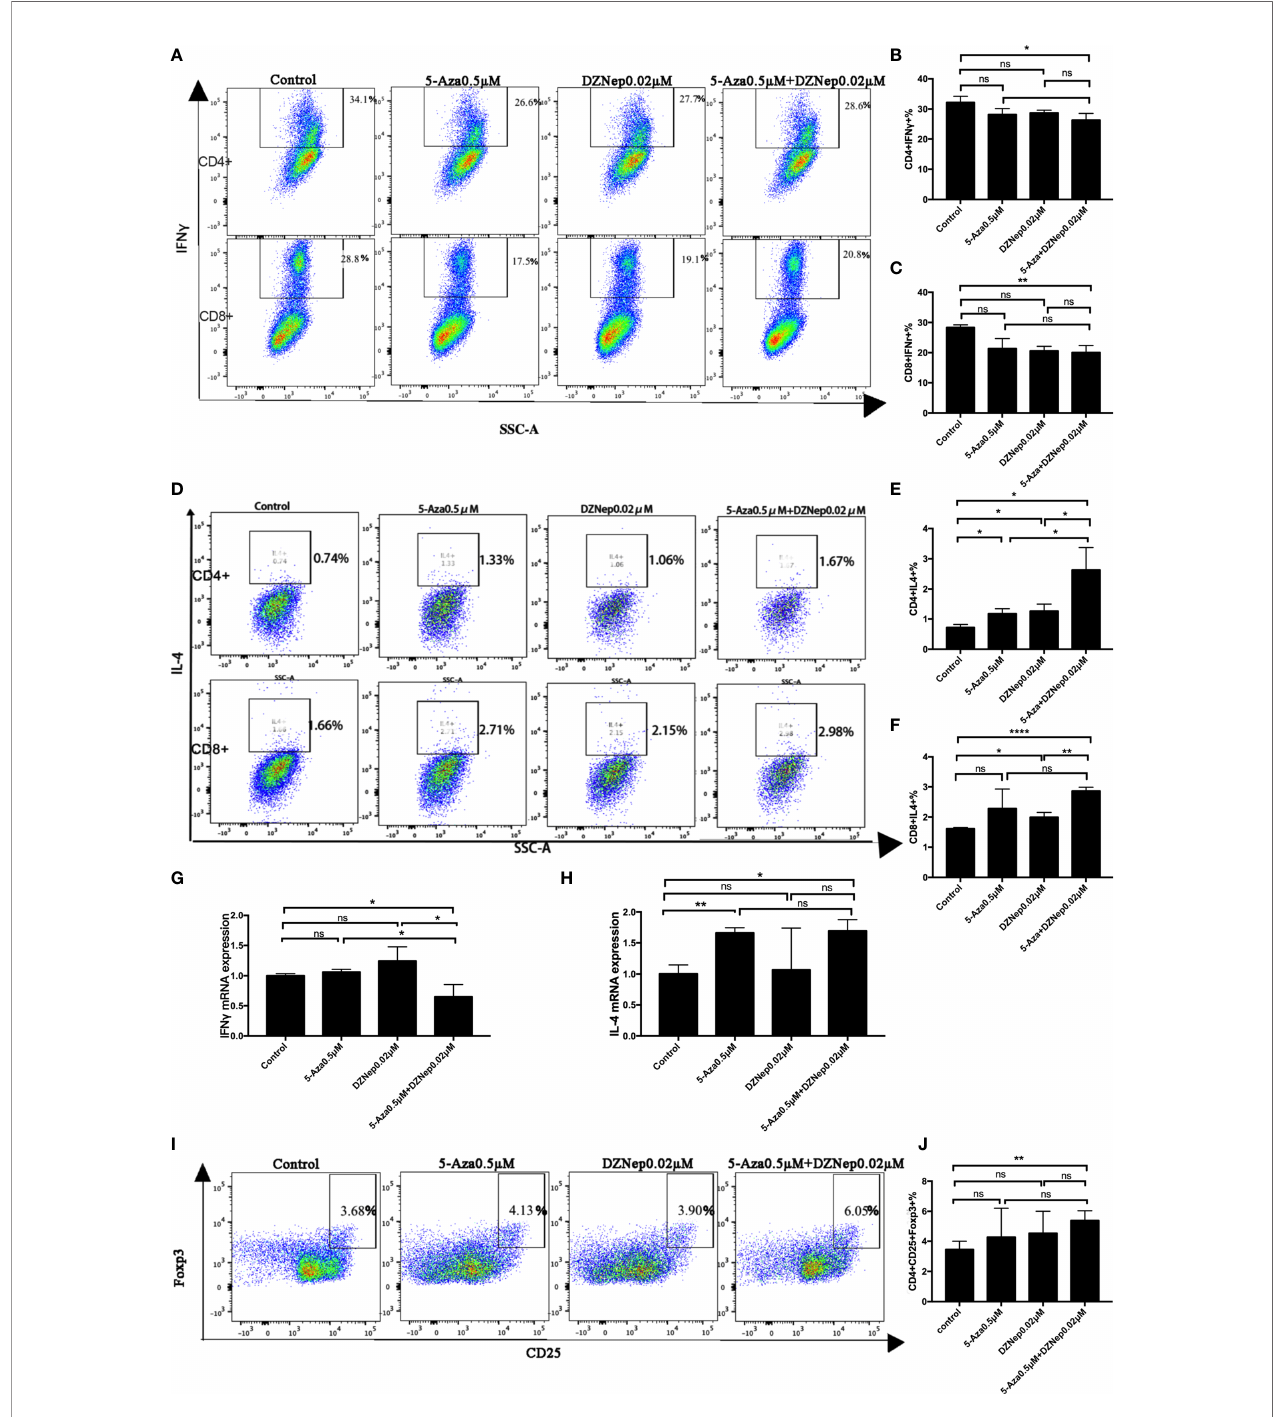
FIGURE 2 | Effects of azacitidine (5-Aza), 3-deazaneplanocin (DZNep), and related combination treatment on T-cell differentiation. (A) Representative fl ow cytometry results of T helper type 1 (Th1) and T cytotoxic type 1 (Tc1) in the different treatment groups. (B, C) Statistical results of Th1 (B) and Tc1 (C) between the different treatment groups. Data shown were representative of three independent experiments. (D) Representative fl ow cytometry results of the percentages of Th2 and Tc2 in the different treatment groups. (E, F) Statistical results of the Th2 (E) and Tc2 (E) percentages between the different treatment groups. (G, H) qPCR results for T- cell IFN g (G) and IL4 (H) expressions. (I) Representative fl ow cytometry result of the ratios of regulatory T cells (Tregs) in the different treatment groups. (J) Statistical analysis of the percentages of Tregs between the different treatment groups. Data shown were representative of three independent experiments. Th1: CD4 + IFN g + cells; Tc1: CD8 + IFN g + cells; Th2: CD4 + IL4 + cells; Tc1: CD8 + IL4 + cells; Tregs: CD4 + CD25 + Foxp3 + . *P < 0.05, **P < 0.01, ****P < 0.0001, ns: P >